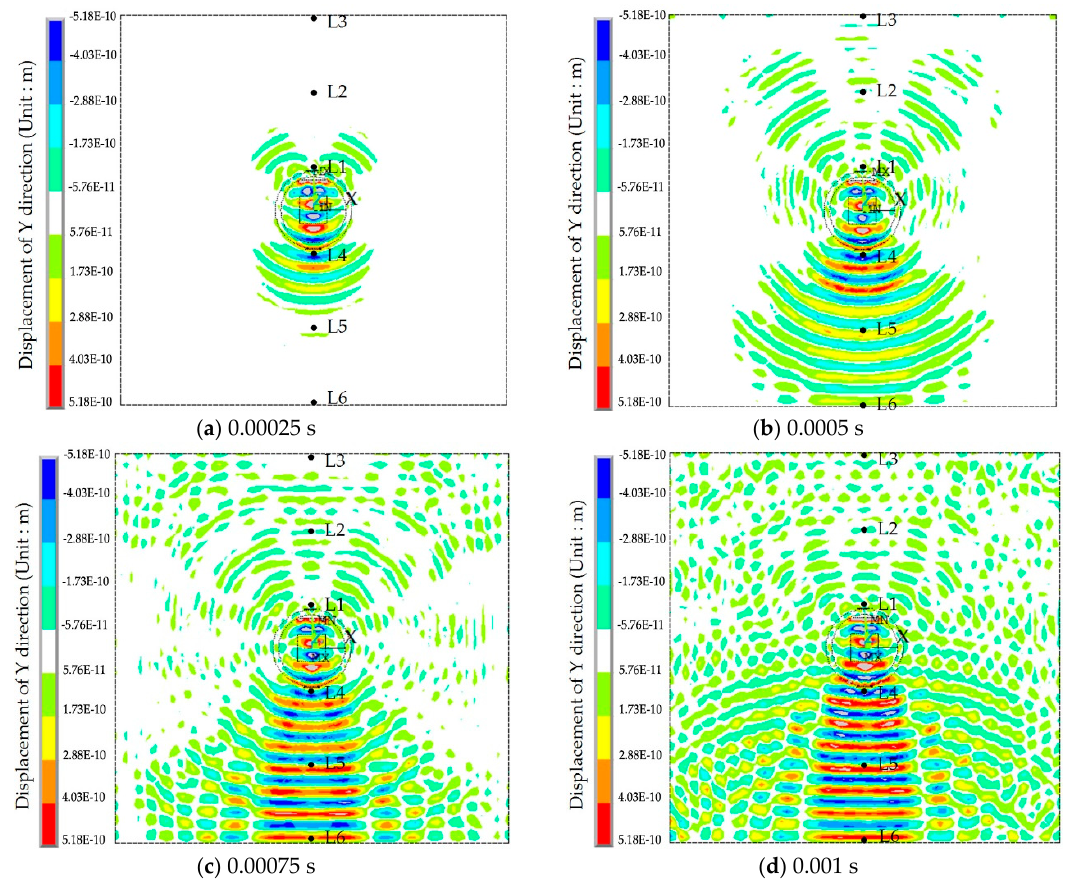
Figure 8. The displacement contour diagram at the 90% grouting level.